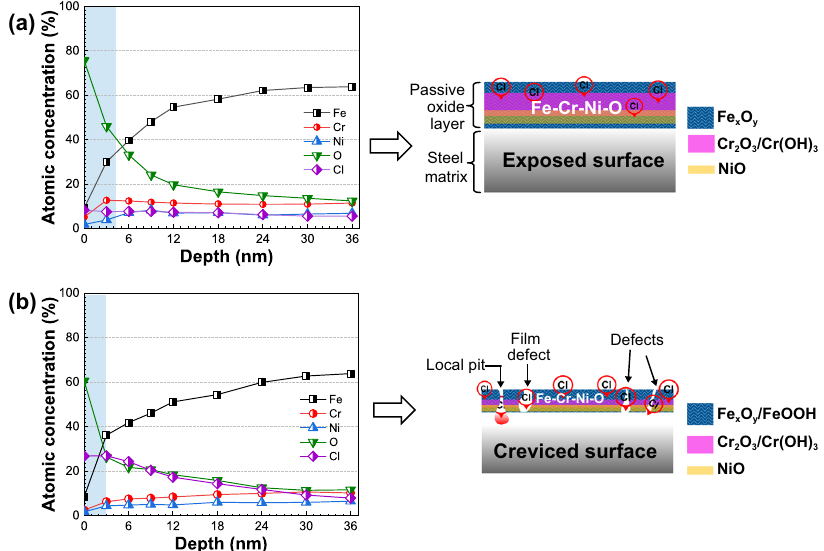
Fig. 6 XPS depth pro fi le showing the percentage element content of the oxide fi lm formed on the surfaces of 304SS after 30 days of immersion in the test media as a function of depth (nm). a Exposed surface, and b crevice surface.